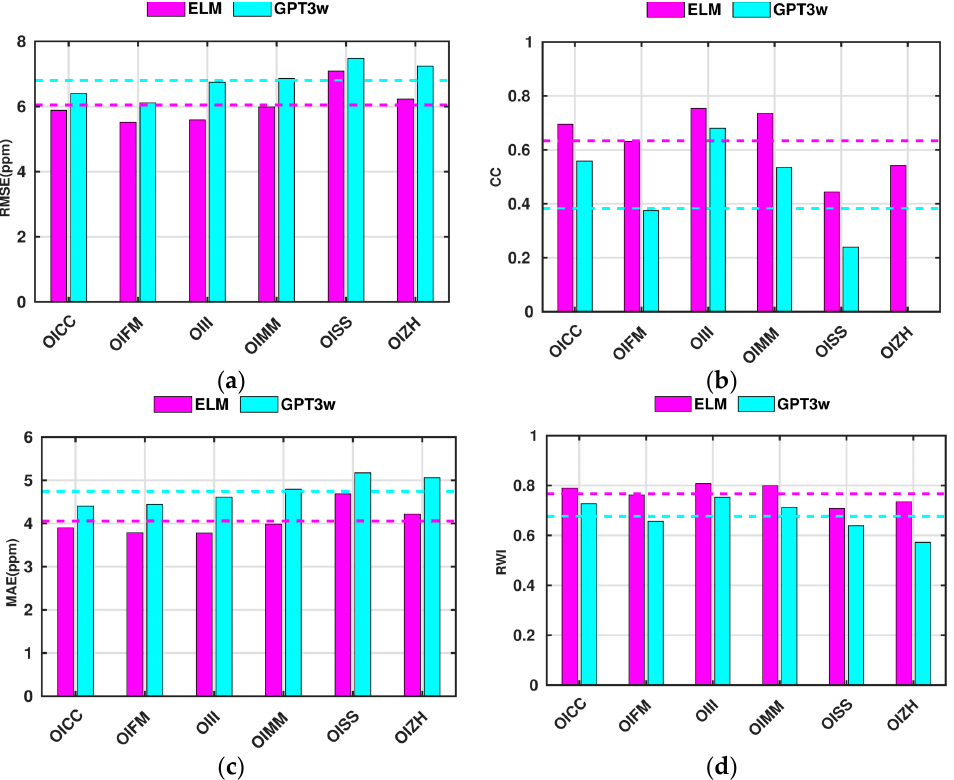
Figure 12. The RMSE (in subplot a ), CC (in subplot b ), MAE (in subplot c ), and RWI (in subplot d ) values for the comparison of the ELM and GPT3w wet refractivity indices with the corresponding radiosonde observations at six stations of this study. The cyan and magenta colors represent the mean value of the statistical measures derived from the ELM and GPT3w models, respectively.